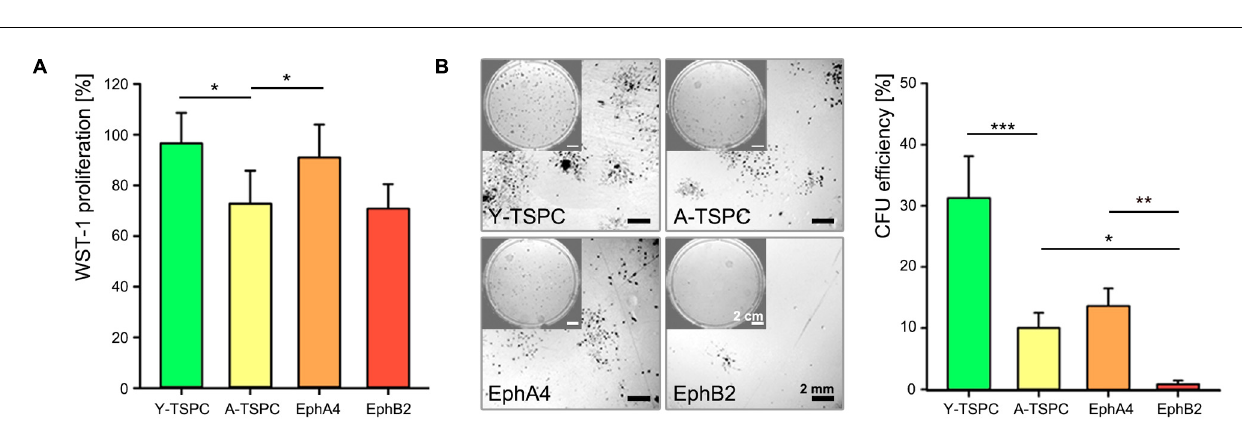
visualized by phalloidin staining at 60 min ( Figure 5B